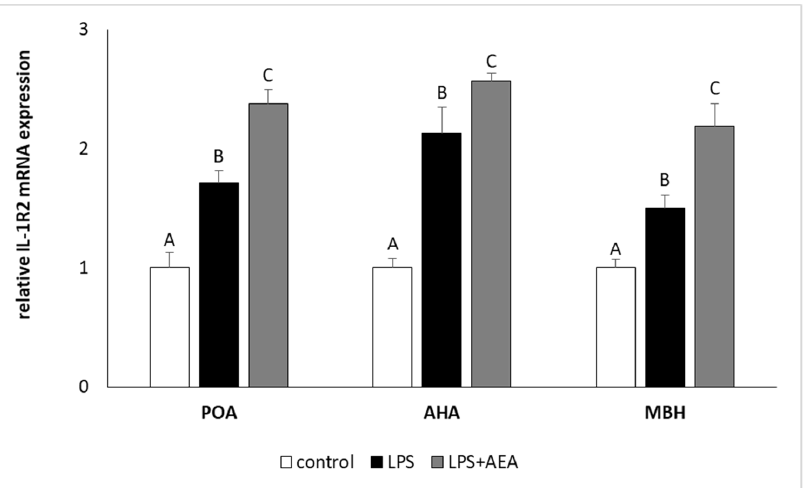
Figure 5. The effect of intravenous (i.v.) anandamide (AEA) injection (10 µ g/kg; i.v.) and lipopolysaccharide (LPS)-induced inflammation (400 ng/mg; i.v.) on the relative receptor type II interleukin 1 (IL-1R2) mRNA level in preoptic area (POA), anterior hypothalamus (AHA), and medial basal hypothalamus (MBH) normalized to the mean expression of three reference genes ( GAPDH , HDAC1 , ACTB —see Table 2). All data are presented as the mean value ± S.E.M. Different letters indicate significant ( p < 0.05) differences according to a one-way ANOVA followed by Fisher’s least significance